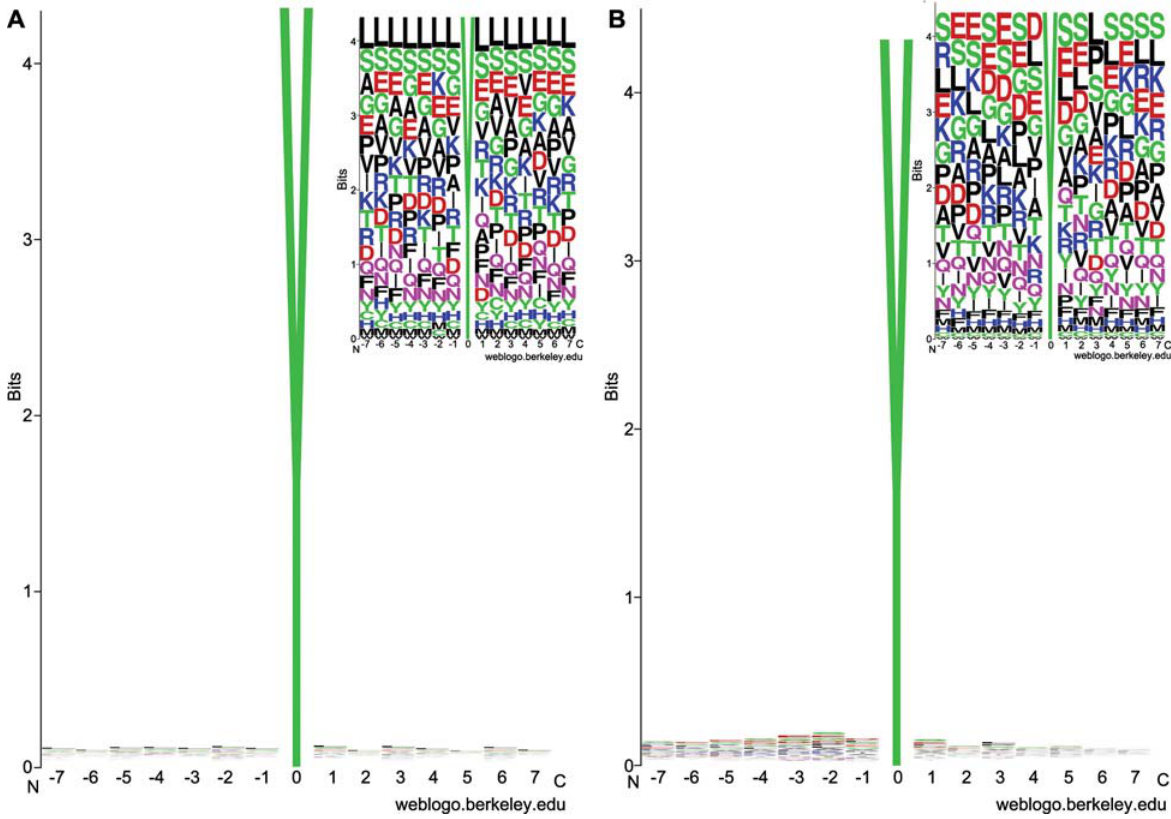
Figure 2 Weblogo analysis of Tyr proteome and phosphoproteome. (A) Weblogo representation of 9962 random peptides centered on Y residues collected as described in the Methods section. In the inset the corresponding frequency plot is reported. (B) Weblogo representation of 9962 phospho-Y peptides from PhosphoSitePlus (cid:2) . In the inset the corresponding frequency plot is